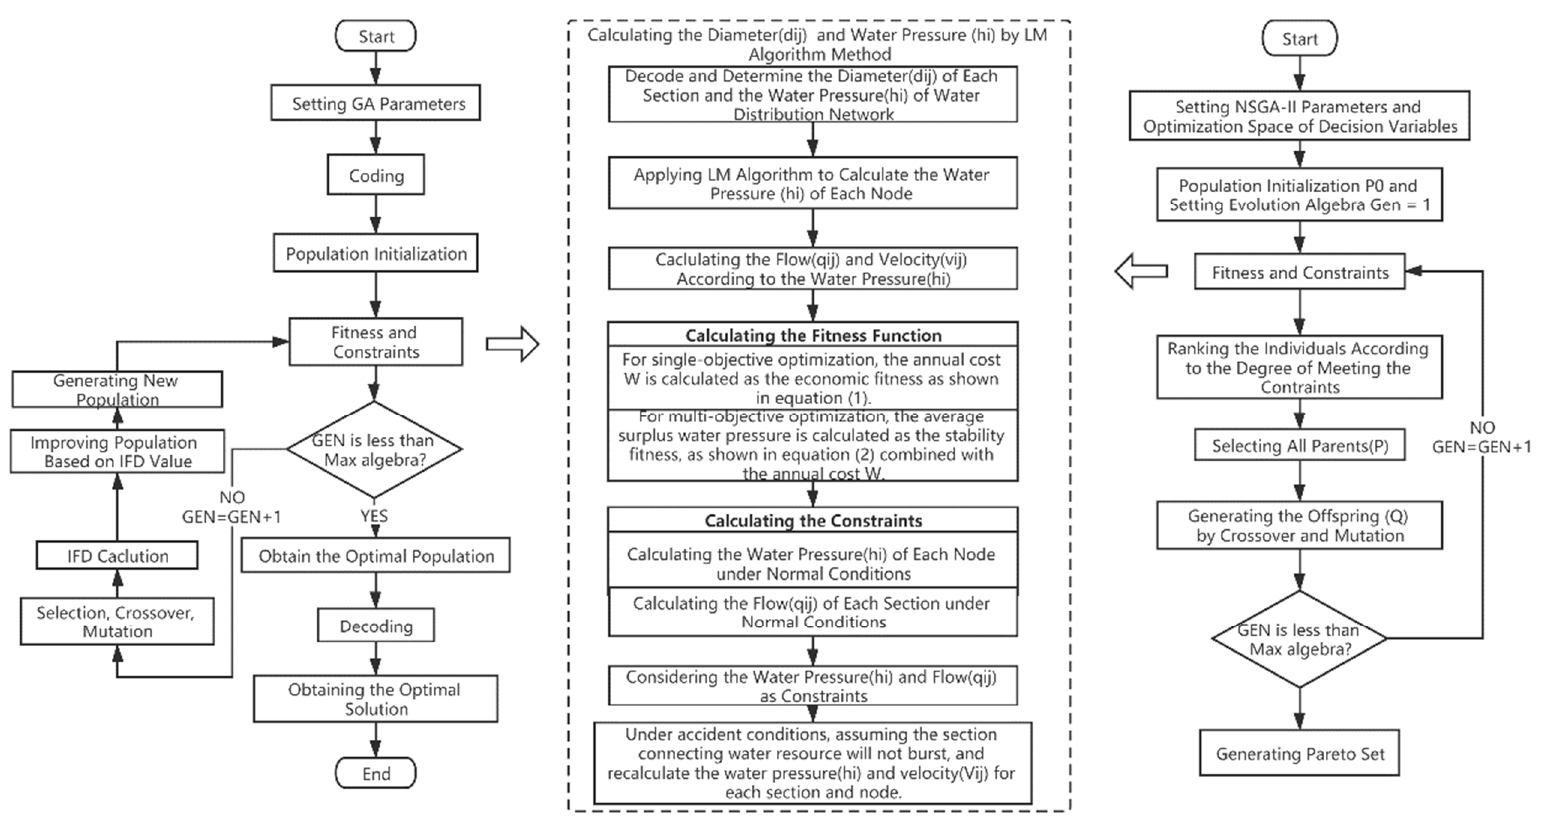
Figure 4. Flow chart of an optimization solution model.